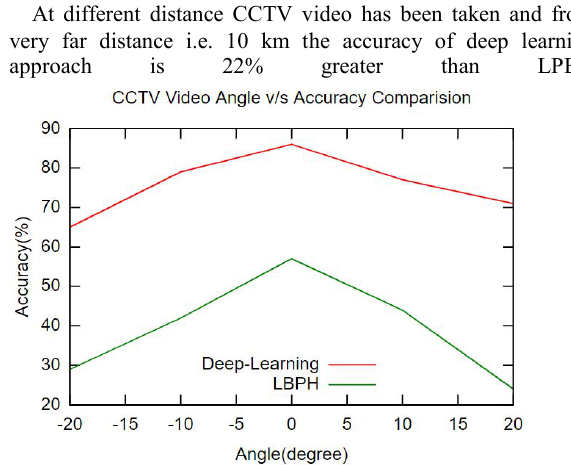
At different distance CCTV video has been taken and from very far distance i.e. 10 km the accuracy of deep learning